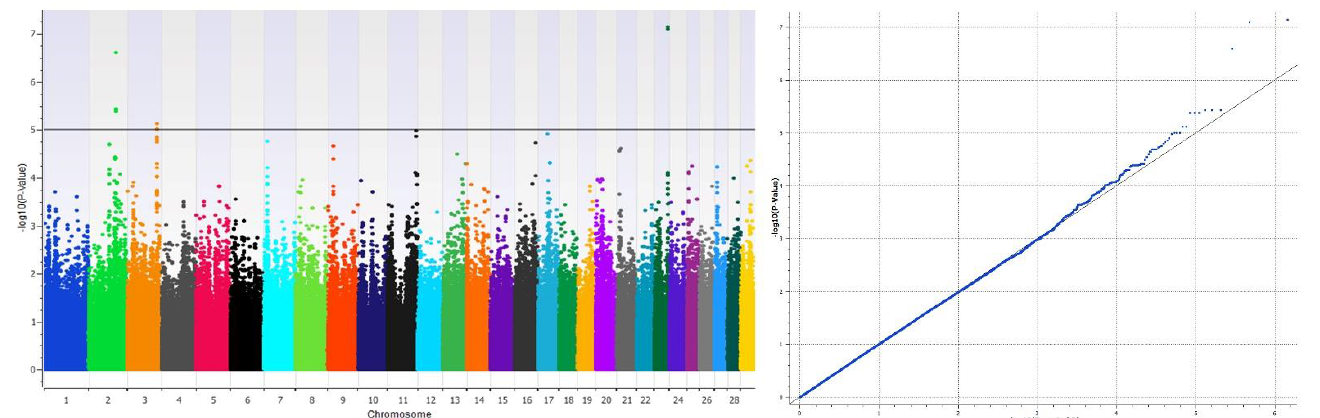
Figure 2. Manhattan plot of the GWAS for variation of the antral follicle count (AFC) in heifers in the left panel and the corresponding qq plot in the right panel. The solid line denotes genome-wide significance at −log( p -value) = 5.